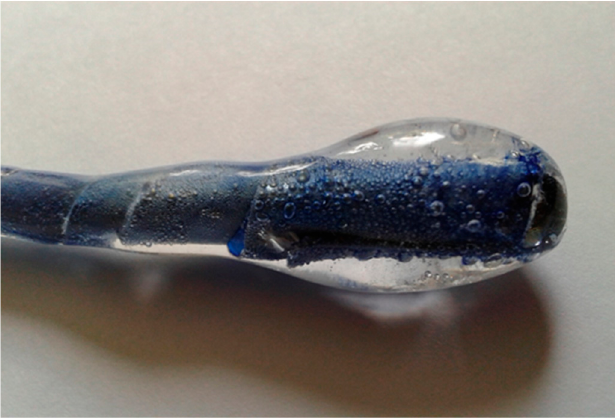
Figure 5. Kovar inclusion applied in borosilicate glass by lampworking; created by author.